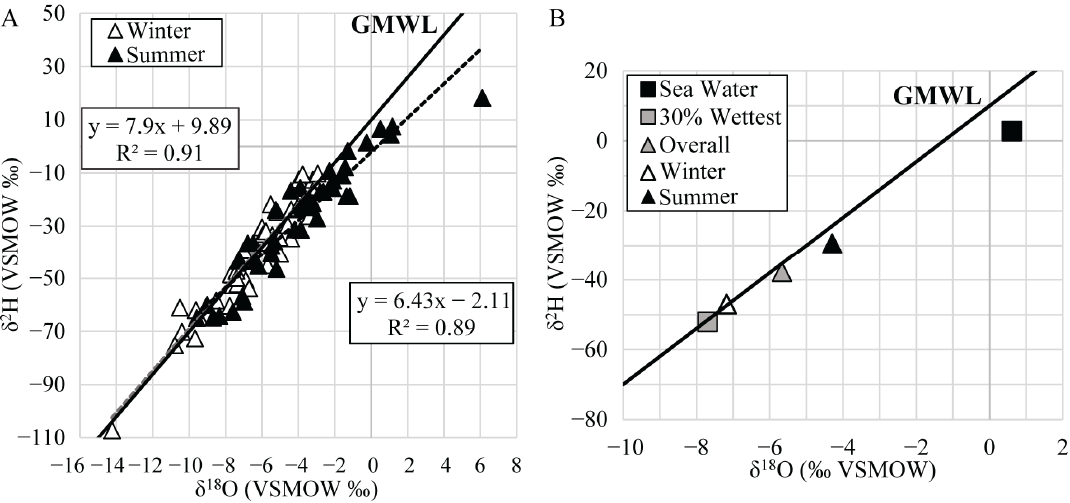
Figure 6. ( A ) δ 2 H vs. δ 18 O values for individual precipitation events collected at OPCNM. ( B )